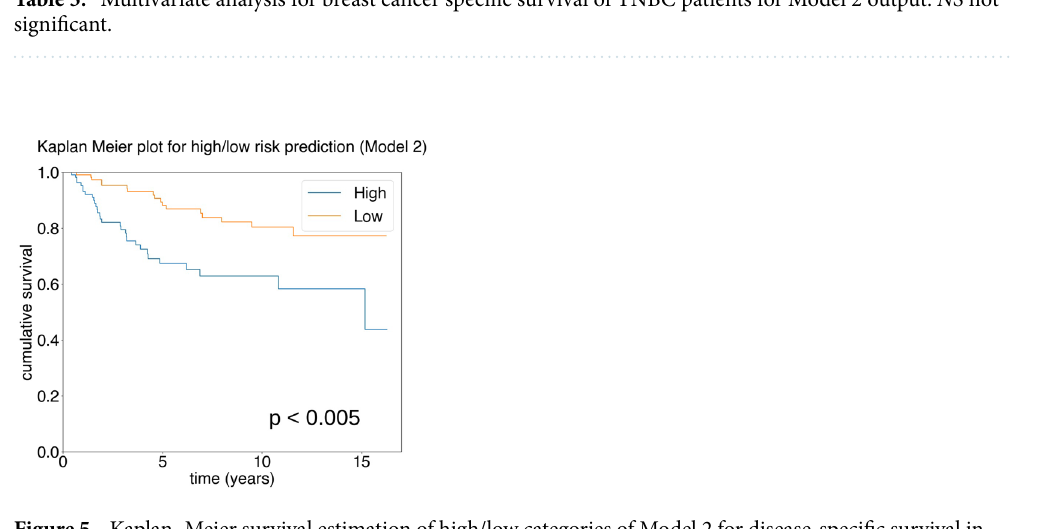
Figure 5. Kaplan–Meier survival estimation of high/low categories of Model 2 for disease-specific survival in TNBC.